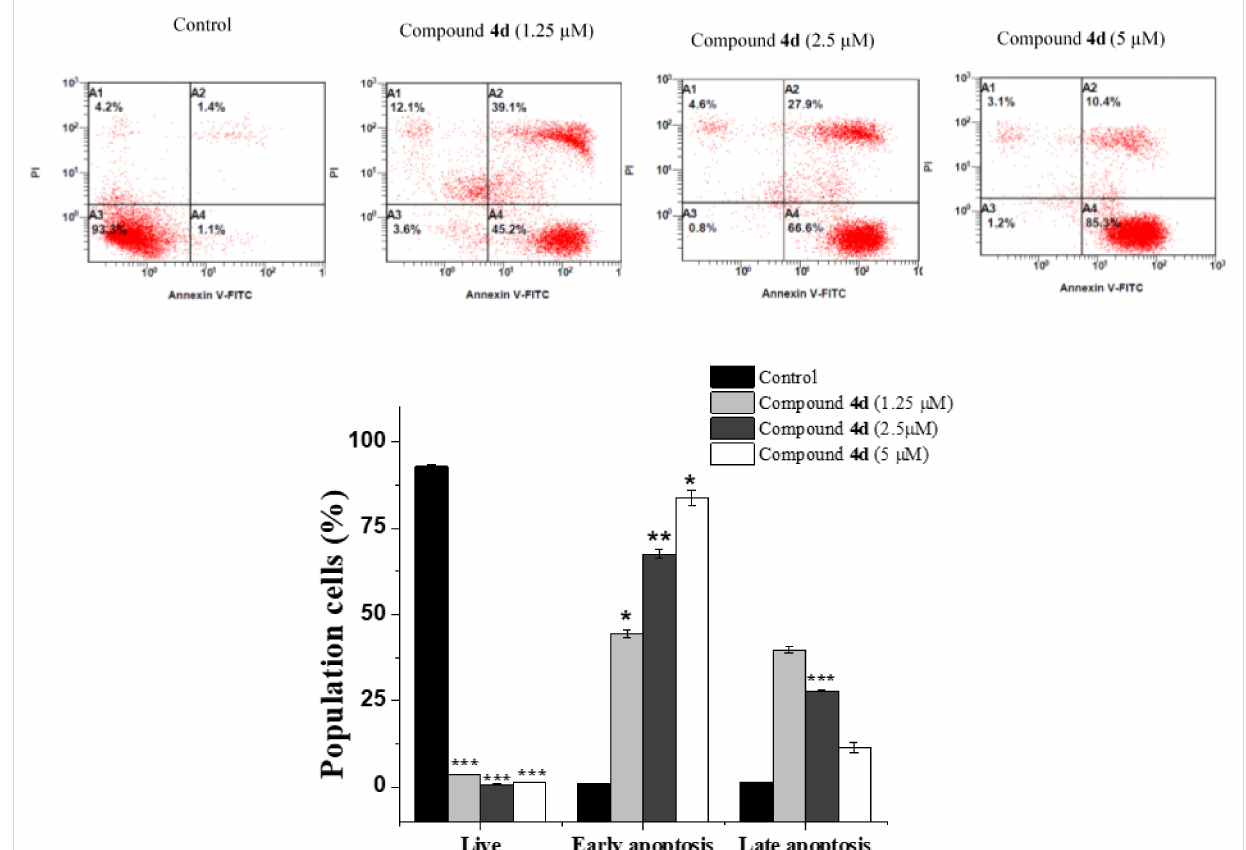
Figure 4. Annexin V-FITC/PI data of untreated and treated MC-7 cells with compound 4d at the indicated concentrations for 24 h. Flow cytometric plot: A3 (live), A4 (early apoptosis), A2 (late apoptosis) and A1 (necrosis). The bar graph depicts the variation in the percentage of cells in different stages. Results are presented as the mean ± SD and differences between treated and control groups were considered statistically significant at * p < 0.05, ** p < 0.01, *** p <